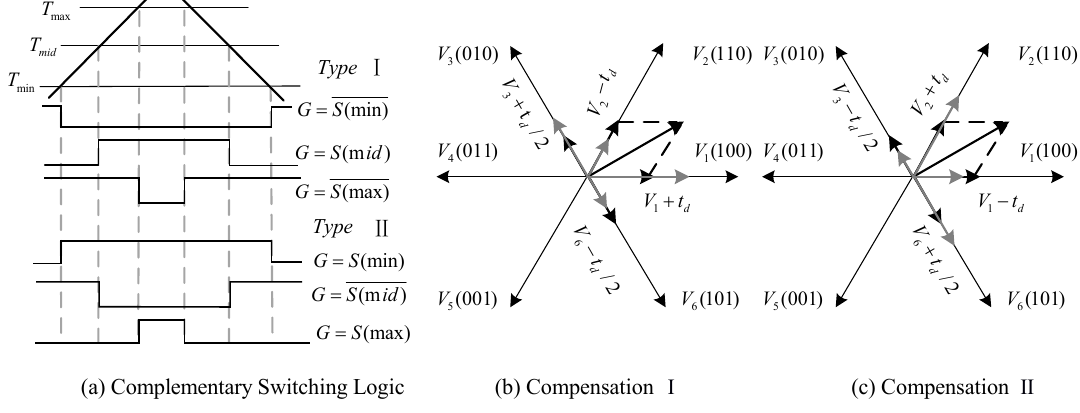
Figure 6. Modified ‐ AZSPWM.